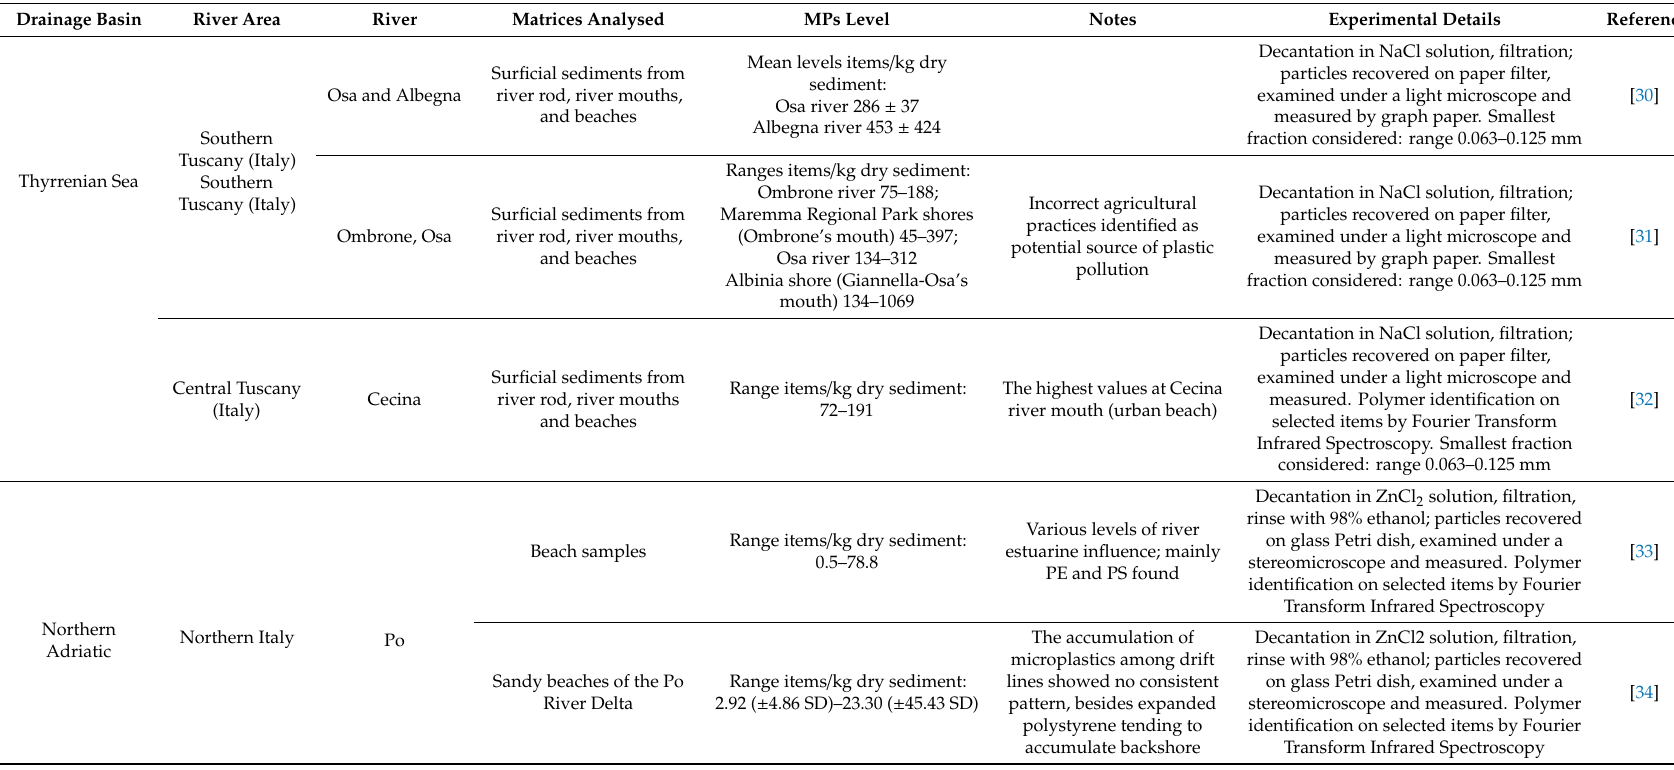
Table 1. Field data and laboratory analytical methods for microplastics (MPs) in environments of Mediterranean Sea tributary